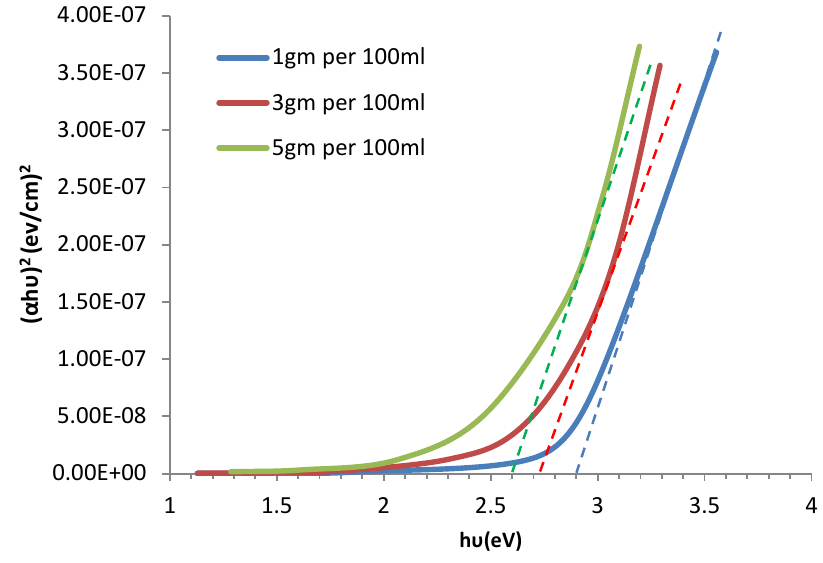
Fig. 2: The Varaition of (αhʋ) 2 versus the photon Energy (hʋ) of PMMA/TiO film at diffenent concentrations of TiO